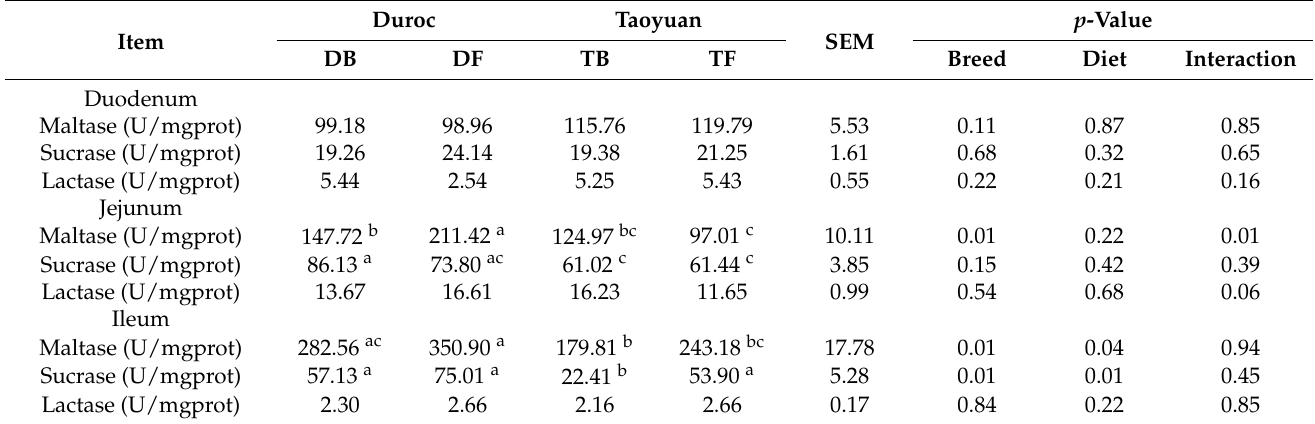
Table 5. Effects of DF on mucosal enzyme activity.